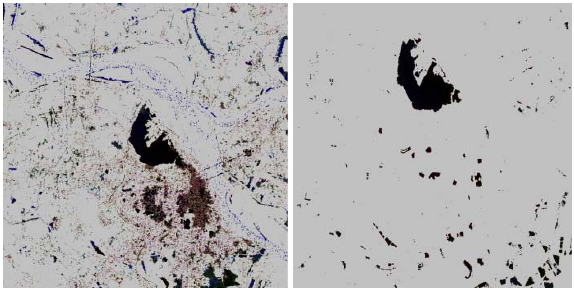
Figure 3. Water by modulation 222222 for Landsat 5 TM (left) and Spot 5 (right)